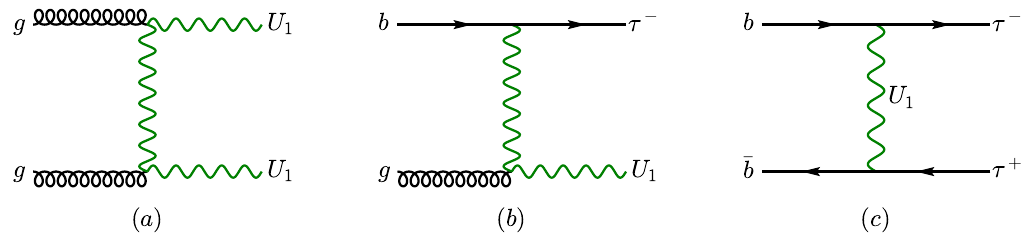
Figure 8 . Representative Feynman diagrams for vector leptoquark pair production (a), single- leptoquark production (b), and t -channel Drell-Yan production